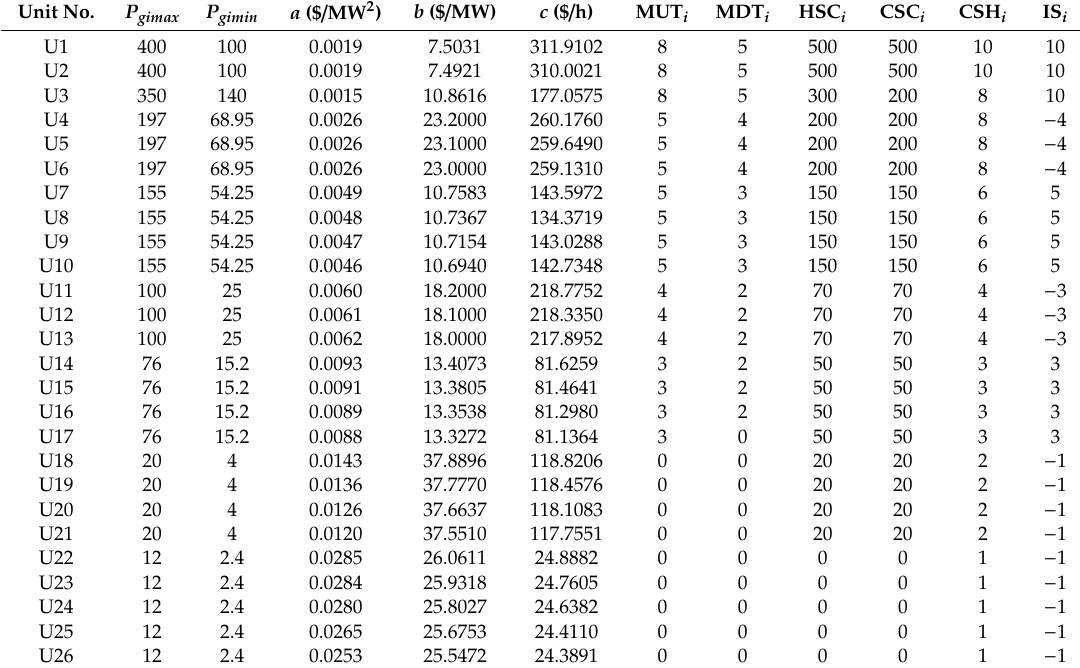
Table 4. System data for 26-unit system.